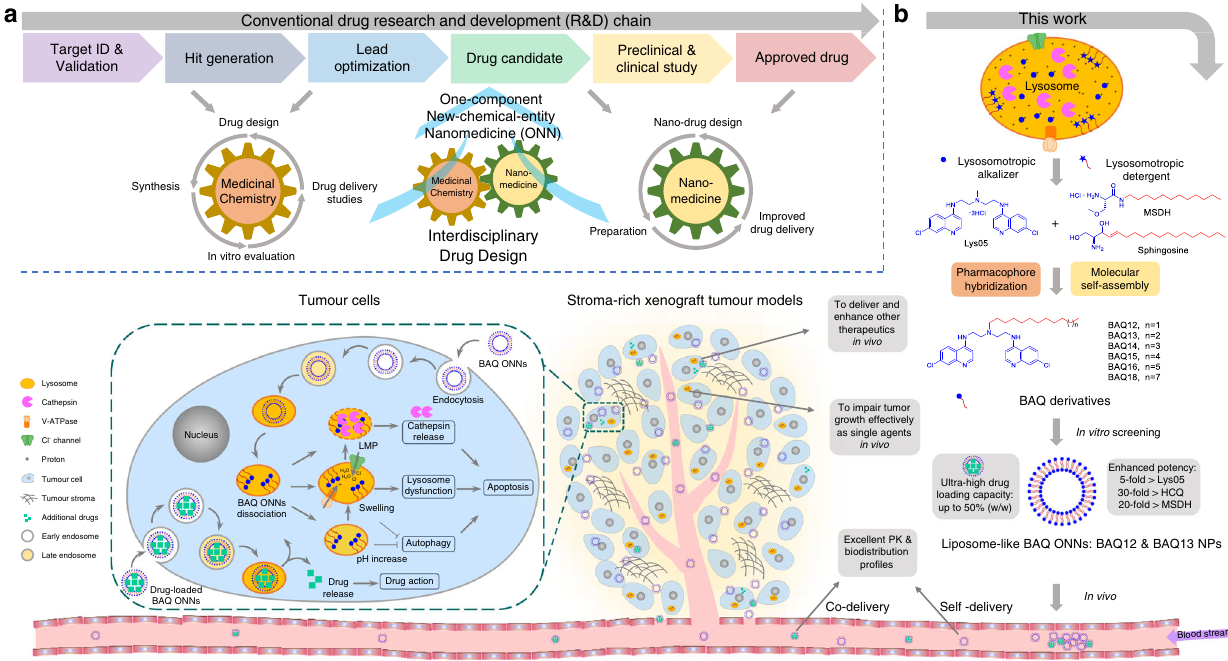
Fig. 1 Schematic illustration of the proposed drug design strategy and the current work. a An interdisciplinary drug design strategy is proposed to integrate the conventional fi elds of medicinal chemistry and nanomedicine. Drugs are named as one-component new-chemical-entity nanomedicines (ONNs), which are designed according to the strategies of conventional drug design and molecular self-assembly so that they could acquire the advantages from the perspectives of both drug discovery and drug delivery. b The proof-of-concept experiment in this work: discovery of self-delivering lysosomotropic bisaminoquinoline (BAQ) derivatives for cancer therapy. The BAQ derivatives, generated from the hybridisation of lysosomotropic detergents and the BAQ-based autophagy inhibitor, can self-assemble into BAQ ONNs that show enhanced functions in vitro, excellent delivery pro fi les and signi fi cant in vivo therapeutic effects as single agents. Moreover, they also possess high drug-loading ef fi ciency to deliver the additional drug into tumour sites, thus generating a promising application of combination